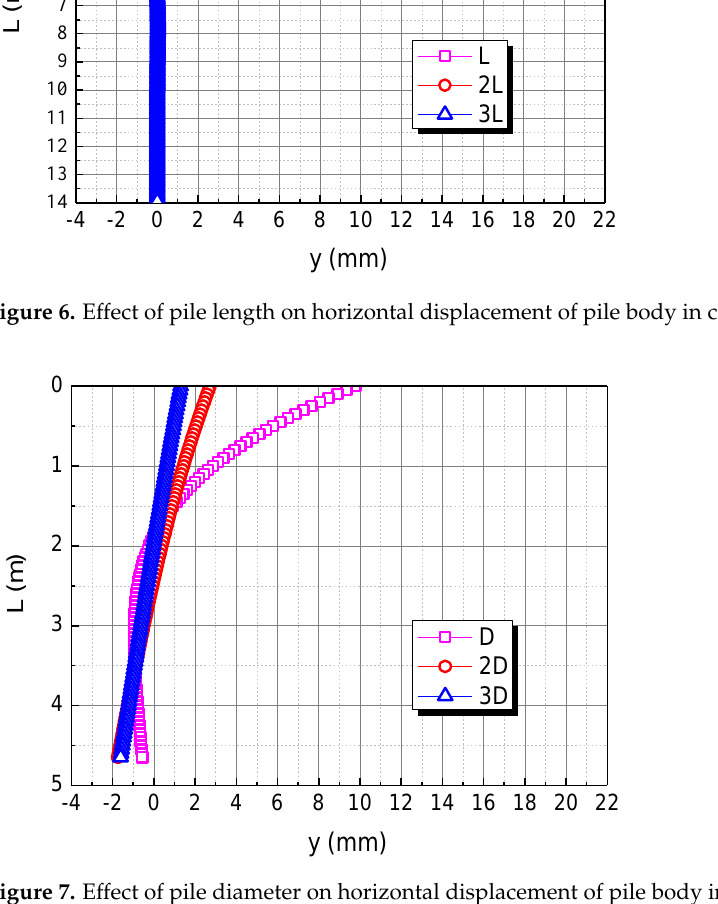
Figure 7. Effect of pile diameter on horizontal displacement of pile body in calcareous sand area.